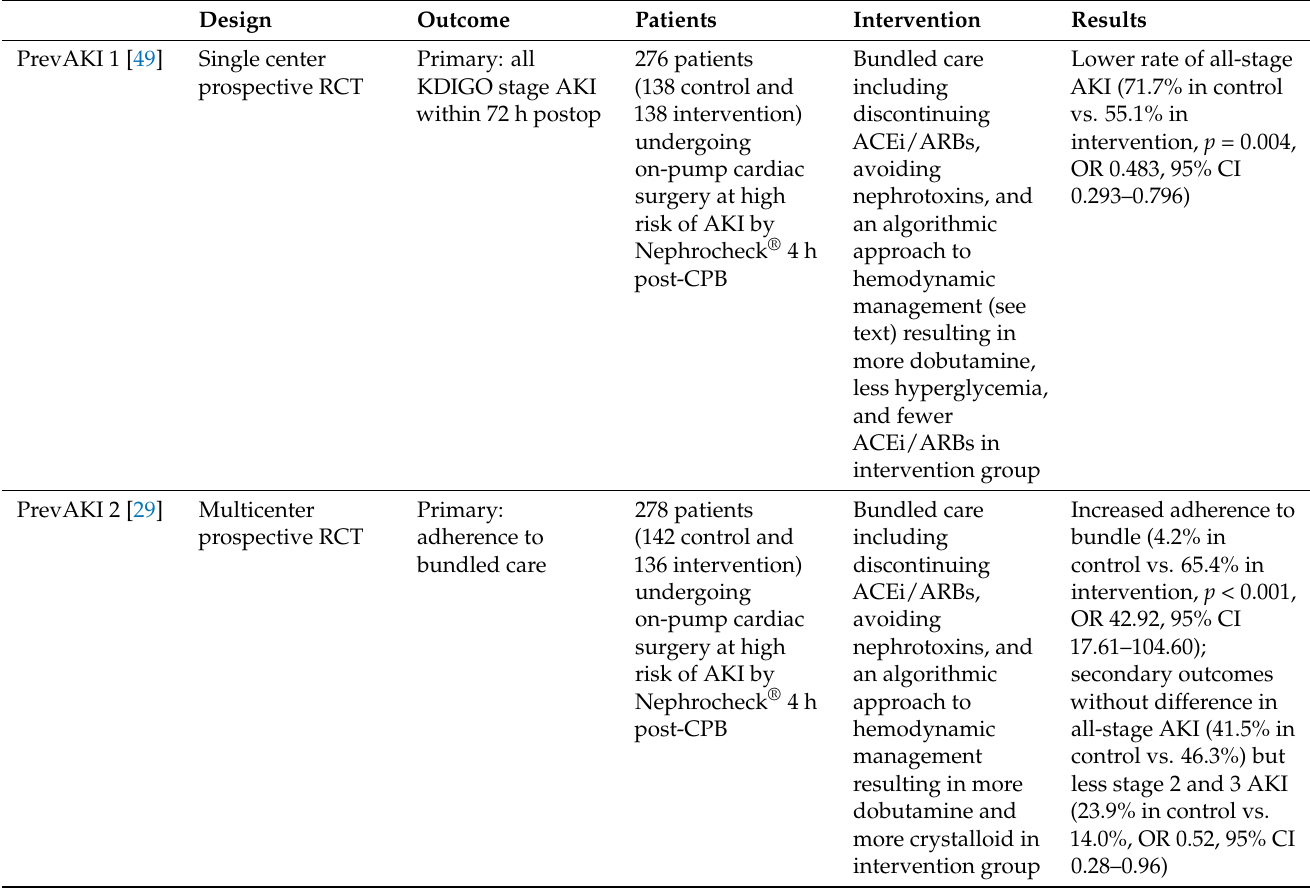
Table 5. Bundled care